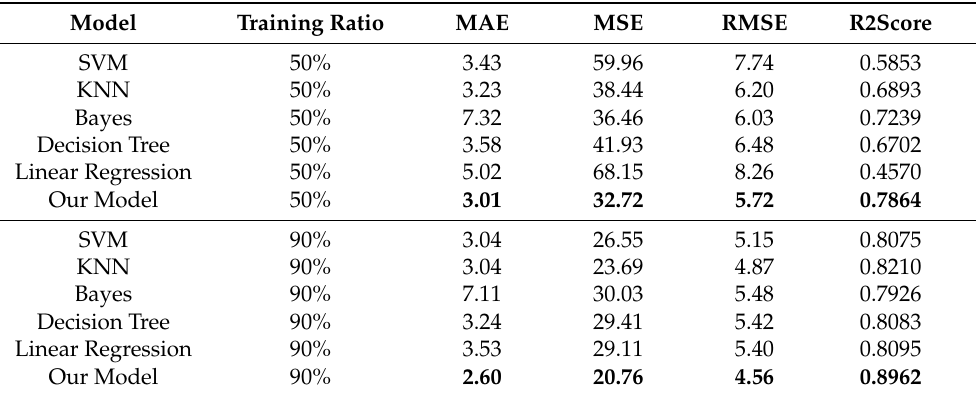
Table 3. Calculation of sentences for different